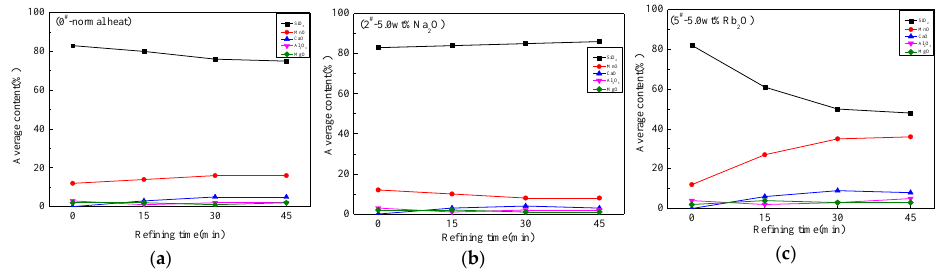
Figure 5. Inclusion distribution overlaid on phase diagram with refining time in 5 # steel sample: ( a ) 900 s (15 min); ( b ) 1800 s (30 min); ( c ) 2700 s (45 min).